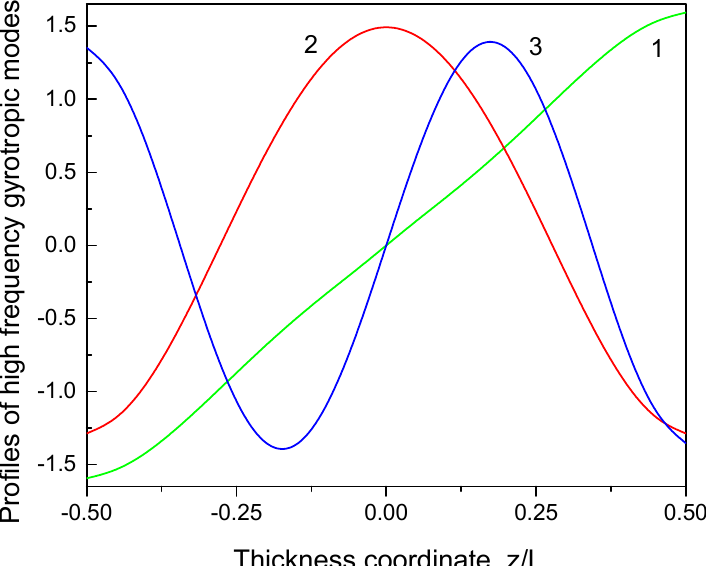
Figure 4. The normalized eigenfunctions of the high-frequency vortex gyrotropic modes with the numbers n = 1, 2, and 3 calculated using the Liouville–Green approximation, Equation (15). The dot aspect ratio β = 1, and the reduced dot radius r = R / L e = 10 .